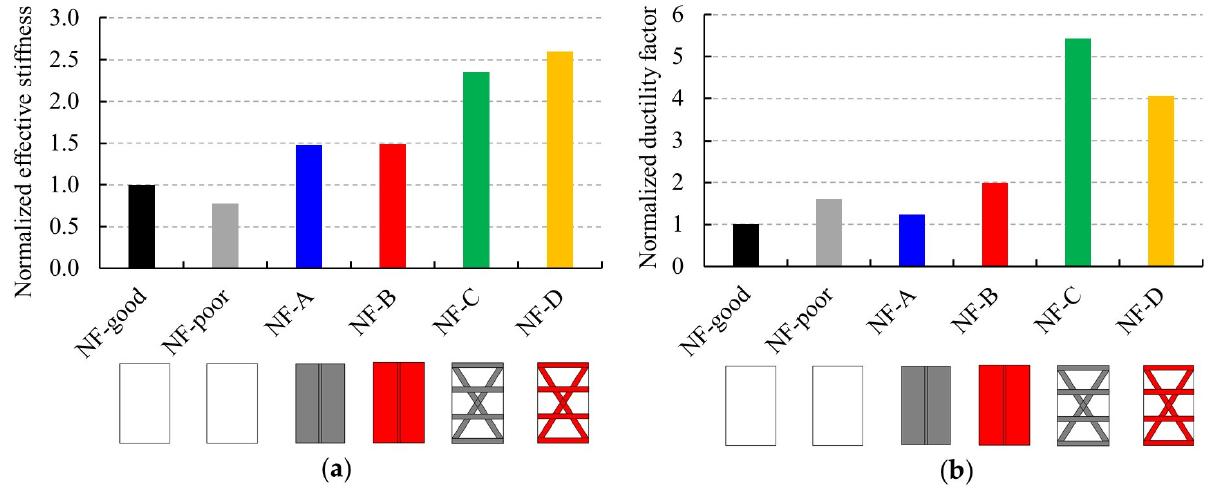
Figure 15. Comparison of: ( a ) average normalized effective stiffness and ( b ) ductility for different strengthening